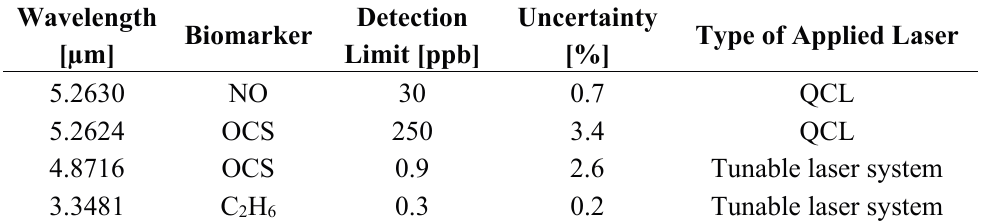
Table 4. Summary of achieved detection limits for selected